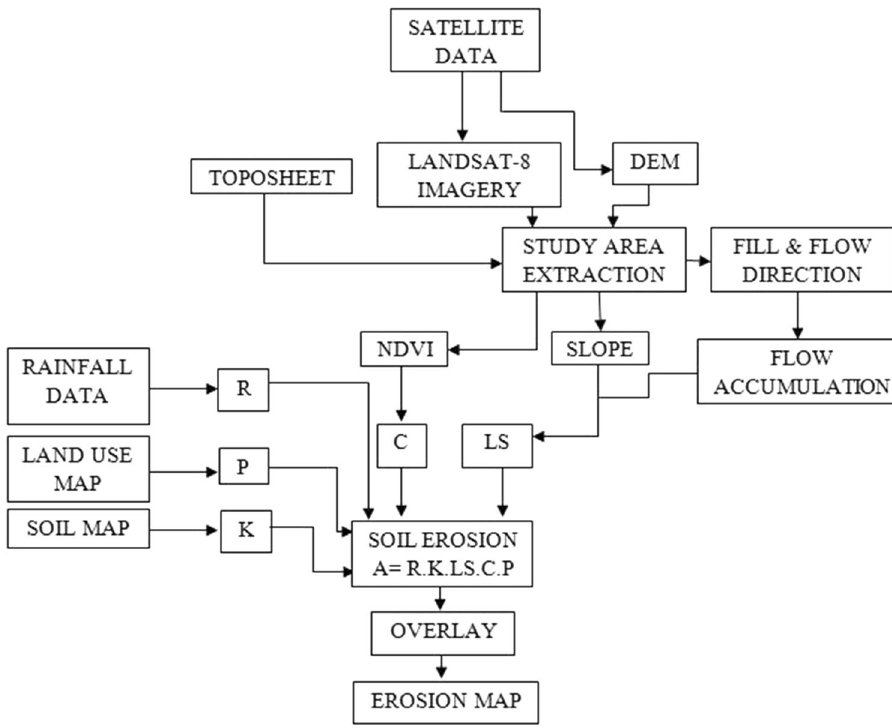
over the study area; the erosivity map is presented in Fig. 4.